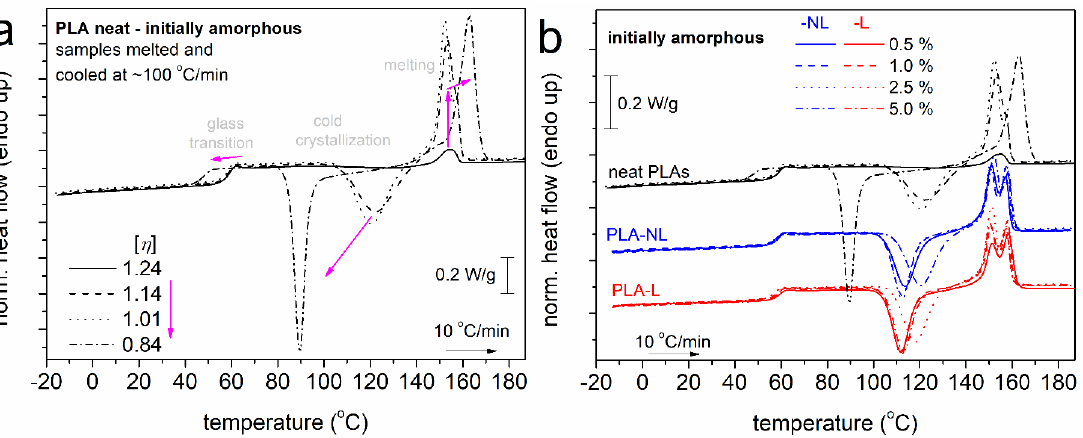
Figure 3. Comparative DSC heating traces for ( a ) neat PLAs of different [η] and ( b ) PLA and PLA − lignin composites, for all samples initially melted and cooled at a fast rate (initially amorphous). The recorded heat flow (in mW) has been normalized to each sample mass (in W/g). In ( a ), the added arrows mark the effects of the decrease in [η].